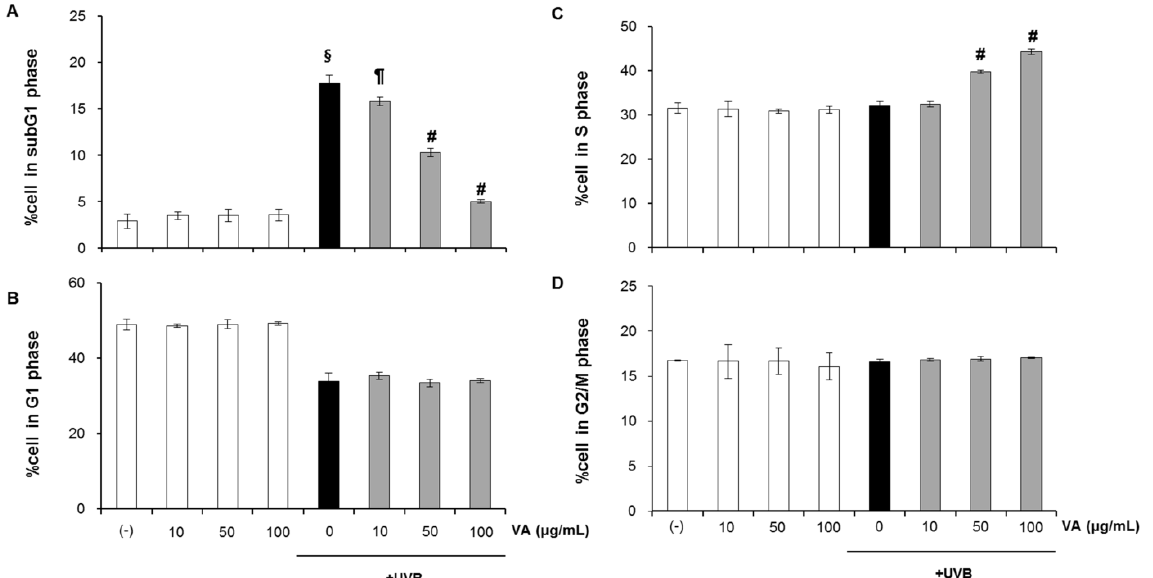
p < 0.01 compared with the vehicle-treated group; # p < 0.01 compared with the UVB treated group; (N = 3); VA: veratric